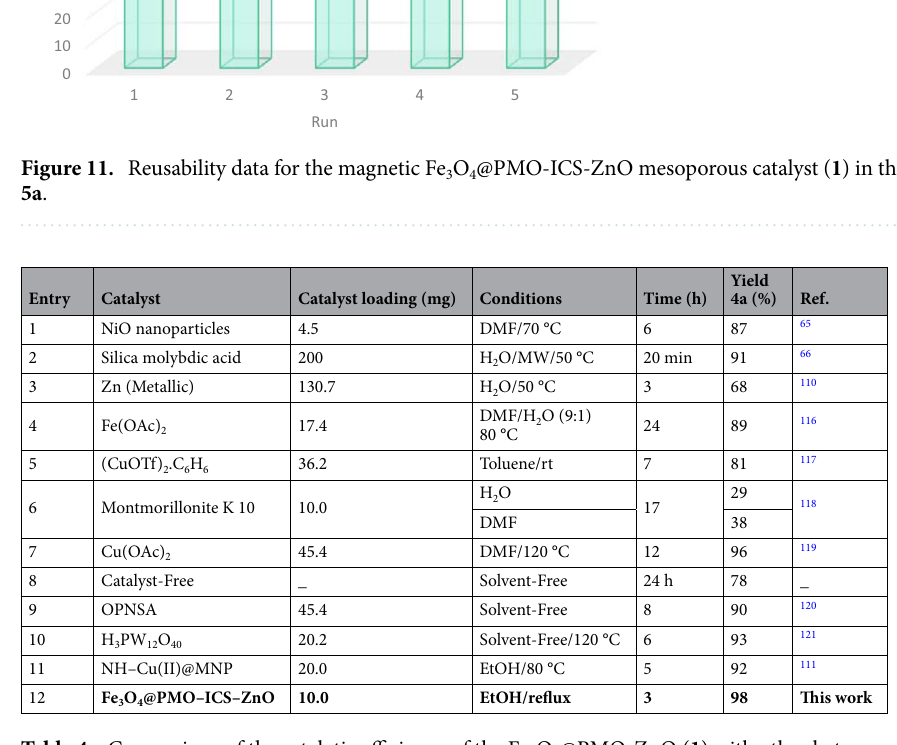
Table 4. Comparison of the catalytic efficiency of the Fe 3 O 4 @PMO-ZnO ( 1 ) with other heterogeneous or homogeneous catalytic systems for the synthesis of 5a . Significant values are in bold.